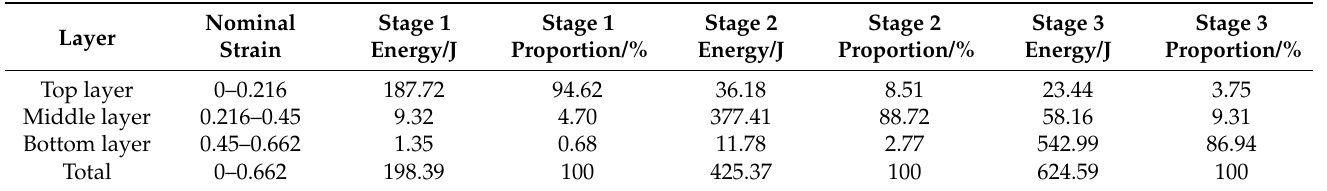
Table 5. The energy absorption of the foam concrete filler at different compression stages ( t = 0.2:0.2:0.2 and ρ = 408:575:848, 1